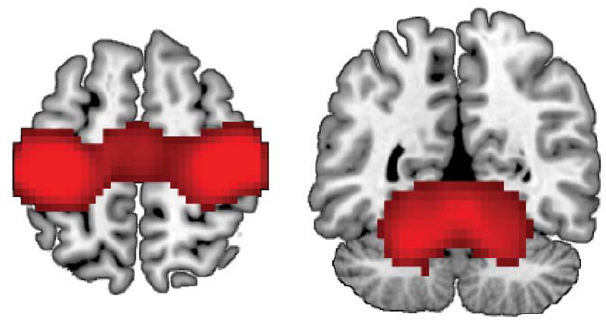
Figure 1. Whole-brain searchlight analysis of the distinctive- ness of motor representations, collapsing across age. Distribut- ed patterns of activation in primary motor cortex, pre-supplementary motor area (left panel; z=56) cerebellum (right panel; y= 2 52) reliably distinguished between left- and right-hand finger tapping. Coordinates are reported in MNI space.